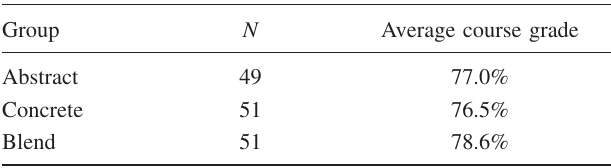
TABLE I. Across-domain study experimental groups.